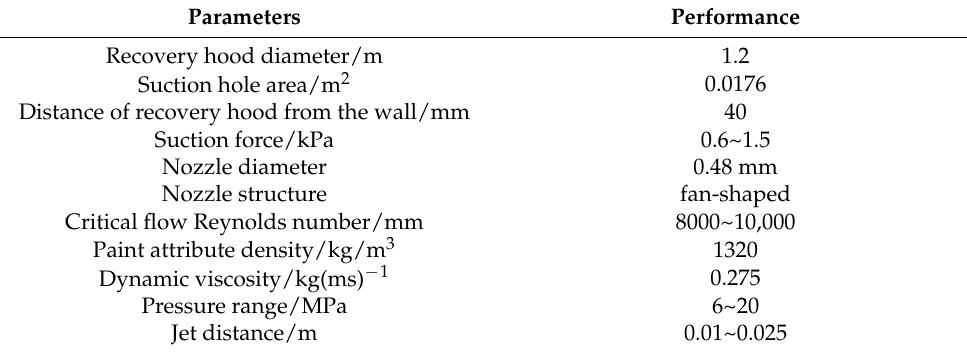
Table 1. Cases of the recovery